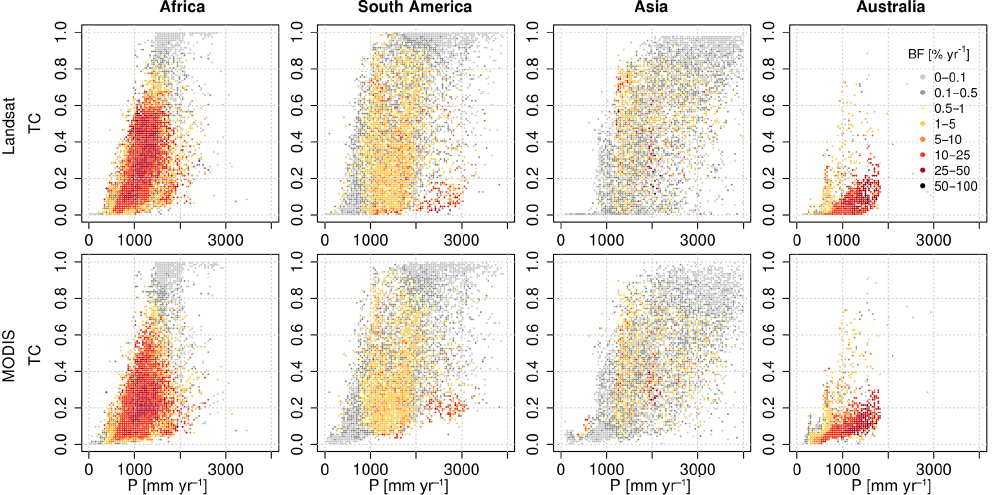
Figure 2. Tree cover (TC) versus precipitation (mmyear − 1 ) with colour-coded burned fraction (BF) for different continents for the two satellite data sets. Burned area is averaged over data points with the same precipitation (40mm steps) and tree cover (in steps of 0.01) to avoid overplotting based on a spatial resolution of 0.25 ◦ . For Asia some higher precipitation values were cut